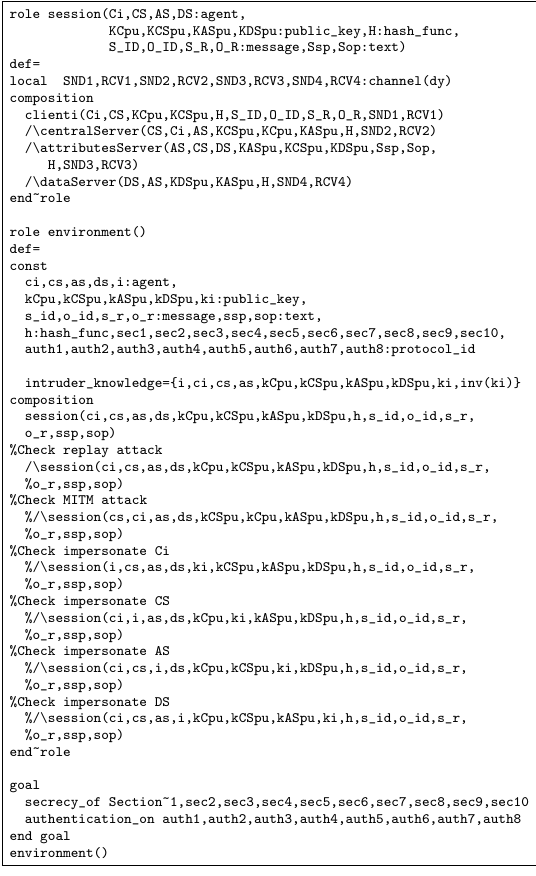
Figure A5. Session, environment, and goal role of PAX in HLPSL.